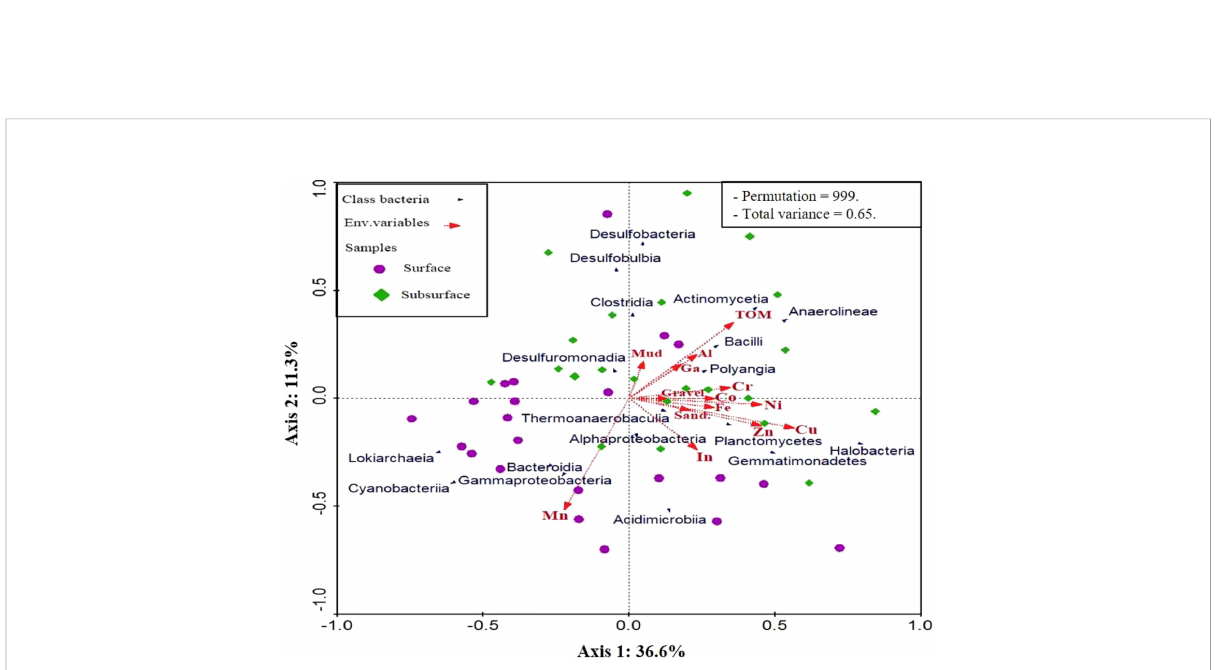
FIGURE 11 Redundancy analysis of the association among environmental variables (red arrows) and microbiota class distribution (blue arrows) across the surface and sub-surface. Statistical signi fi cances were determined by the Monte Carlo permutation test (p <